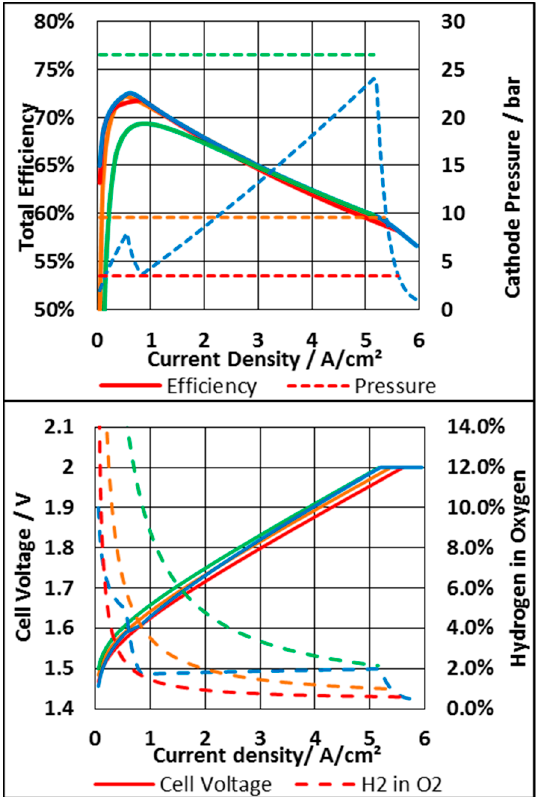
Figure 8. Top : Total efficiency and cathode pressure as a function of current density. Bottom : Polarization curve and hydrogen concentration in oxygen as a function of current density. The different pressures are colorized: 26.5 bar (green), 9.6 bar (orange), 3.5 bar (red), pressure optimization (blue). The curves refer to the use of an N212 membrane.